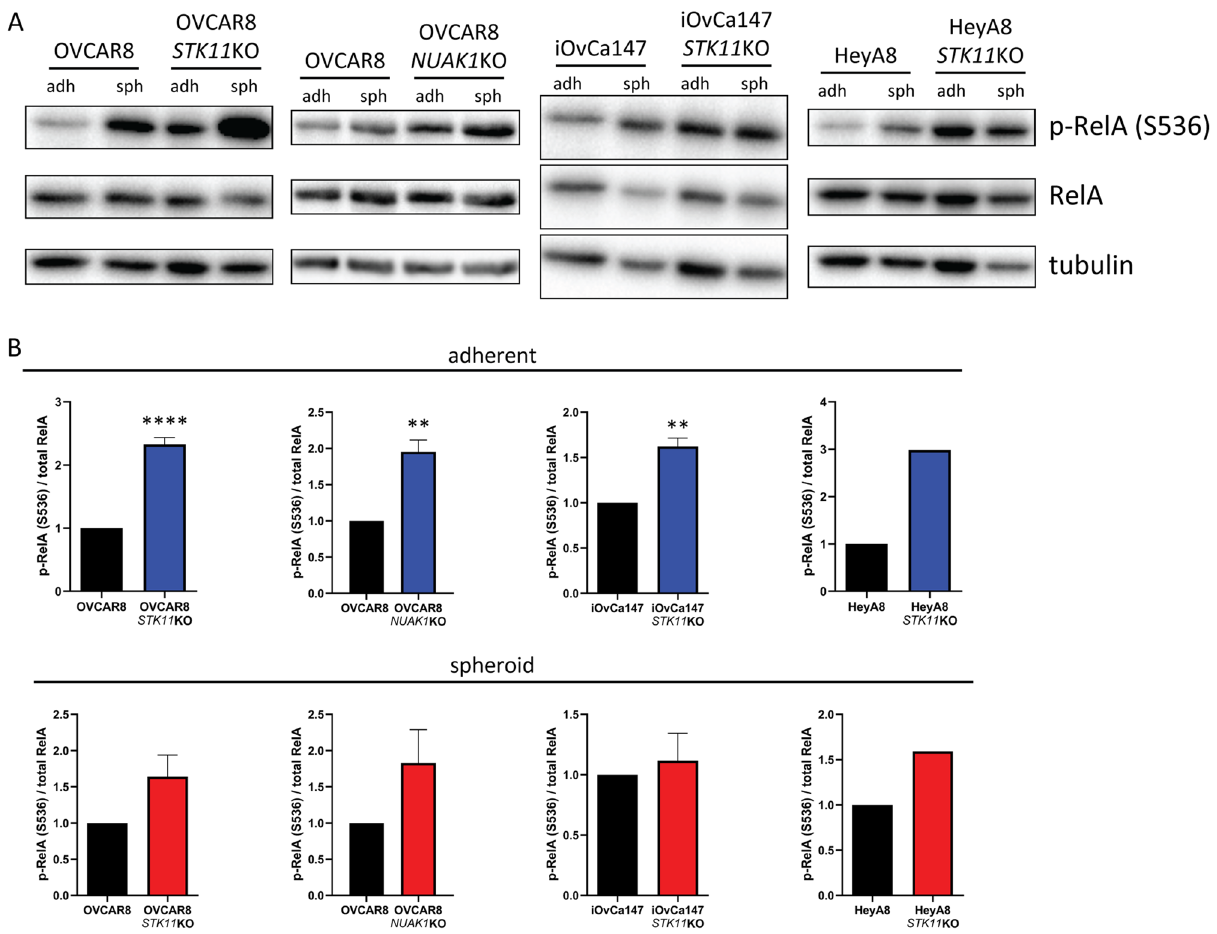
Figure 2. Increased phosphorylation of RelA at S536 in EOC cell lines lacking LKB1 or NUAK1. ( A ) Representative immunoblots for p-RelA-S536 in OVCAR8- STK11 KO, OVCAR8- NUAK1 KO, iOvCa147- STK11 KO, and HeyA8- STK11 KO cell lines and parental lines grown in adherent (adh) and spheroid (sph) culture conditions. Total RelA and tubulin were used as controls. ( B ) Densitometric analysis of p-RelA-S536 expression with data from adherent culture of knockout cell lines shown in blue and spheroid culture of knockout cell lines are shown in red. Knockout cell lines were compared with parental cell controls (OVCAR8 and iOvCa147) by unpaired, two-tailed Student’s t -test (*p ≤ 0.05, **p ≤ 0.01, ****p ≤ 0.001; n = 3). Error bars indicate standard error of the mean